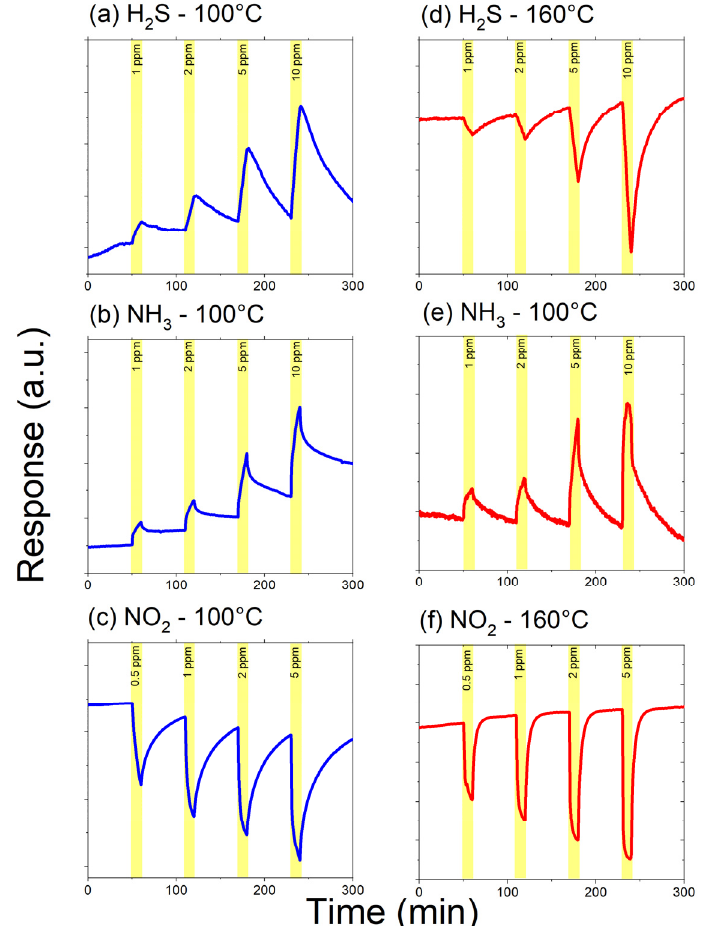
Figure 9. Dynamic response–recovery curves from sensors based on rGO–50 v / v %–In 2 O 3 nanocom- Figure 9 . Dynamic response–recovery curves from sensors based on rGO–50 v/v%–In 2 O 3 nanocom- posites operating at different temperatures towards H 2 S at 100 °C ( a ) and 160 °C ( d ); towards NH 3 posites operating at different temperatures towards H 2 S at 100 ◦ C ( a ) and 160 ◦ C ( d ); towards NH 3 at at 100 °C ( b ) and 160 °C ( e ); and towards NO 2 at 100 °C ( c ) and 160 °C ( f ). 100 ◦ C ( b ) and 160 ◦ C ( e ); and towards NO 2 at 100 ◦ C ( c ) and 160 ◦ C ( f Table 2. Variation function of microsensor resistance during exposure step to gases for 2 different working temperatures. The gas can be identified from the sign of resistance variations.